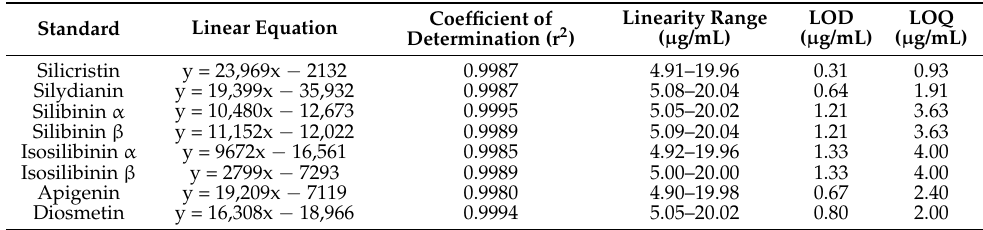
Table 2. Linearity and Sensitivity Data of All Standards.